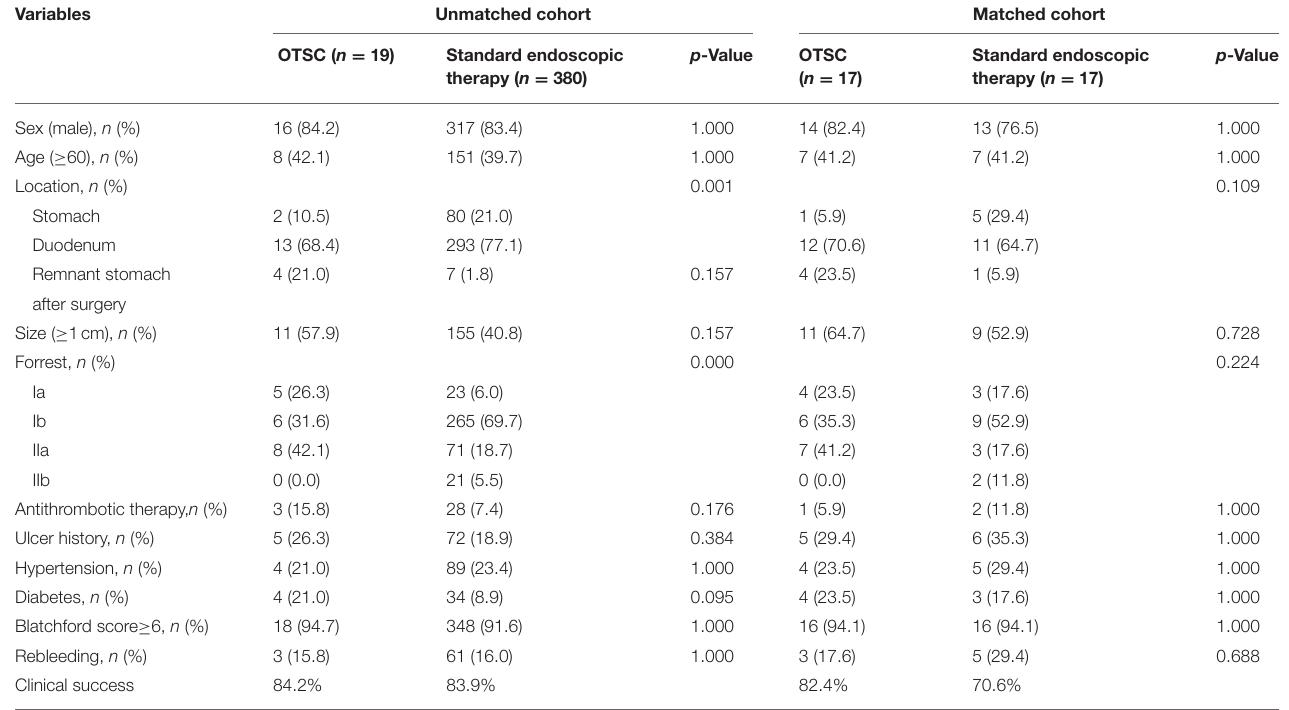
TABLE 4 | Clinical characteristics of the patients with ulcers in the unmatched and matched cohorts. Variables Unmatched